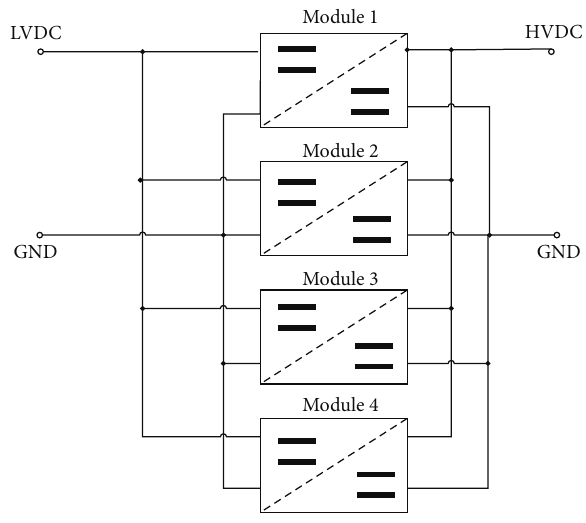
Figure 1: PIPO connection